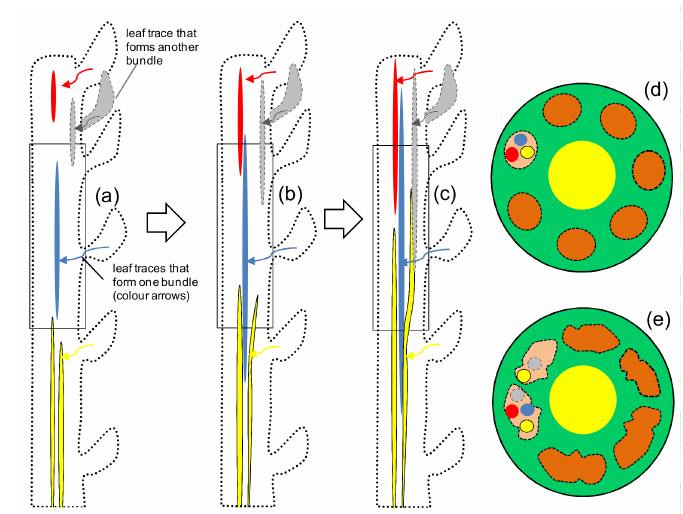
Figure 2. The direction of intrusive growth affects the bundle structure. ( a – c ) successive elongation steps of fibers with different direction of growth in considered stem zone; ( d ) fibers coming from different leaf traces can follow the way made by fibers that originated from the considered leaf trace and have already intruded themselves in between other cells, i.e., slide along “beaten path”. In this case, bundles have “right” shape, ( e ) some of the fibers make their “own” way (yellow fiber) leading to anastomose between fiber bundles. In this case, different bundles can contain fibers from neighbour leaf traces, not strongly from traces located one bellow other